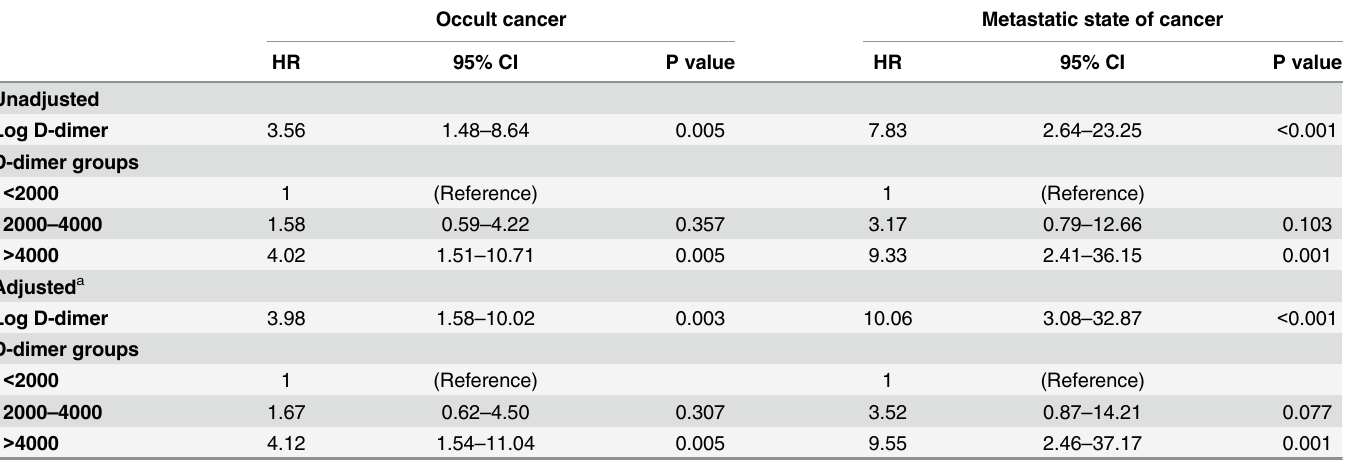
Table 4. Cox regression for the likelihood of occult or metastatic cancer according to D-dimer. Occult cancer Metastatic state of